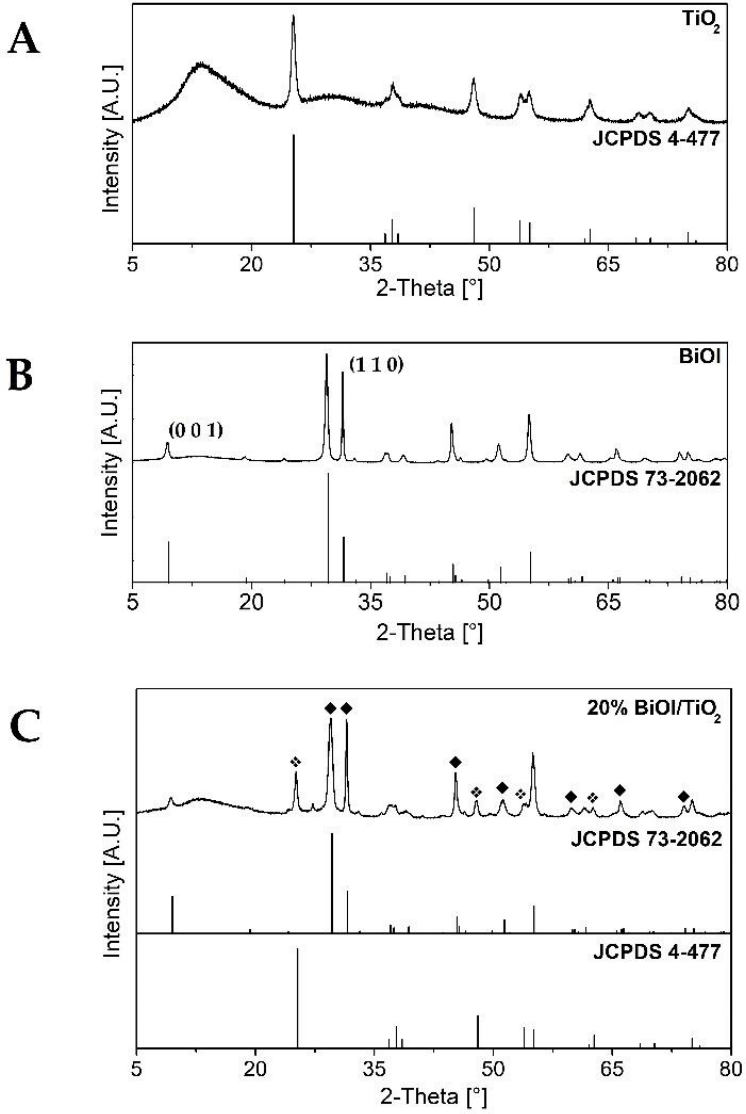
Figure 1. Powder XRD patterns of ( A ) titanium dioxide; ( B ) bismuth oxyiodide; ( C ) 20% BiOI/TiO 2 . ◆ crystalline facet of bismuth oxyiodide. ❖ crystalline facet of titanium dioxide. It has been reported that the exposure ratio of (1 1 0)/(0 0 1) planes is important in the photocatalytic activity of bismuth oxyiodide because of the ability of (1 1 0) planes to generate hydroxyl radicals under visible light irradiation [23]. It can be observed